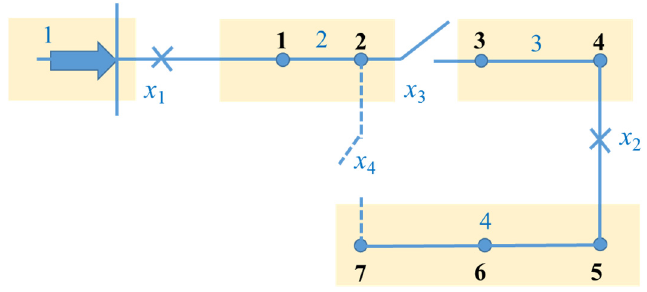
Figure 3. A diagram for a sectionalized distribution